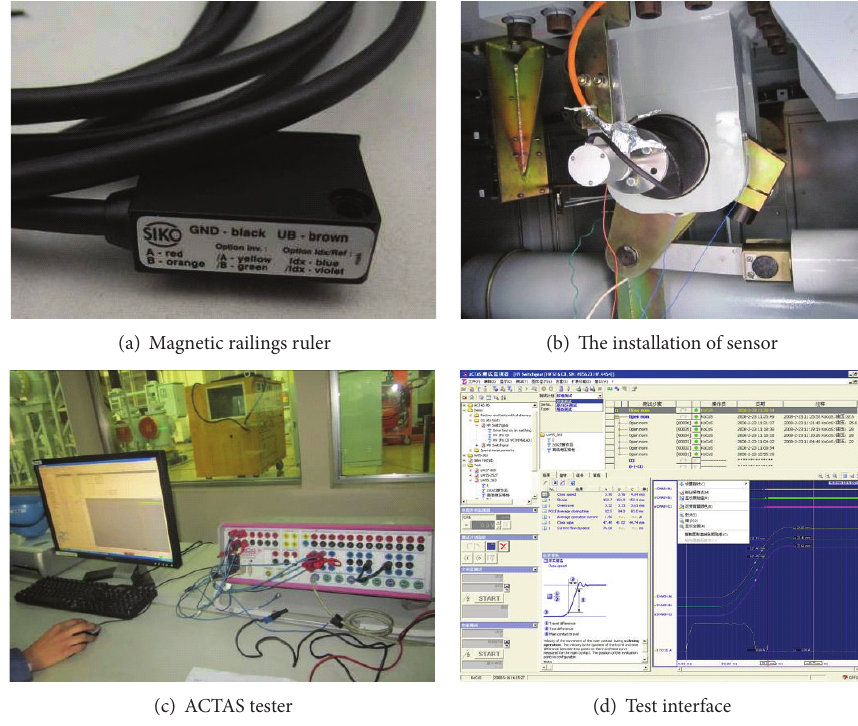
Figure 9: Experimental test system.